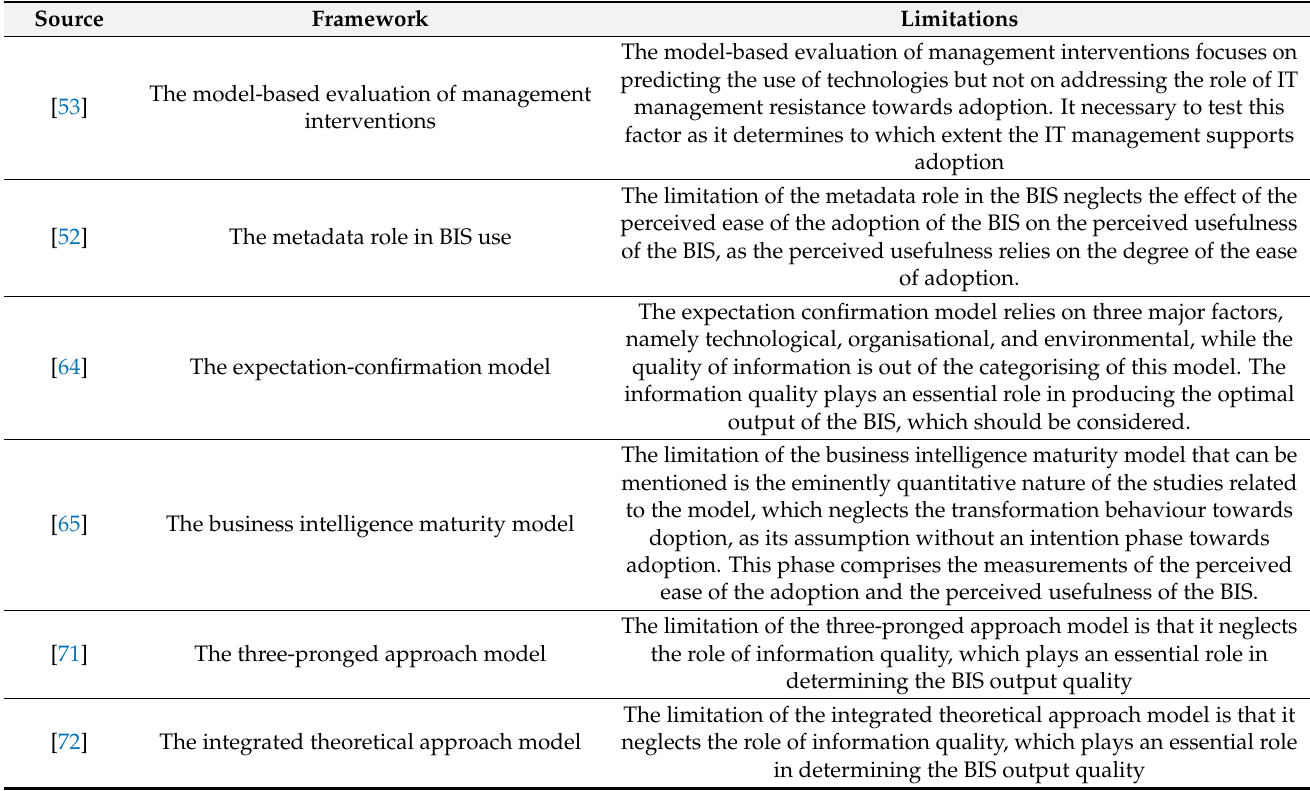
Table 1. The previous framework for BIS